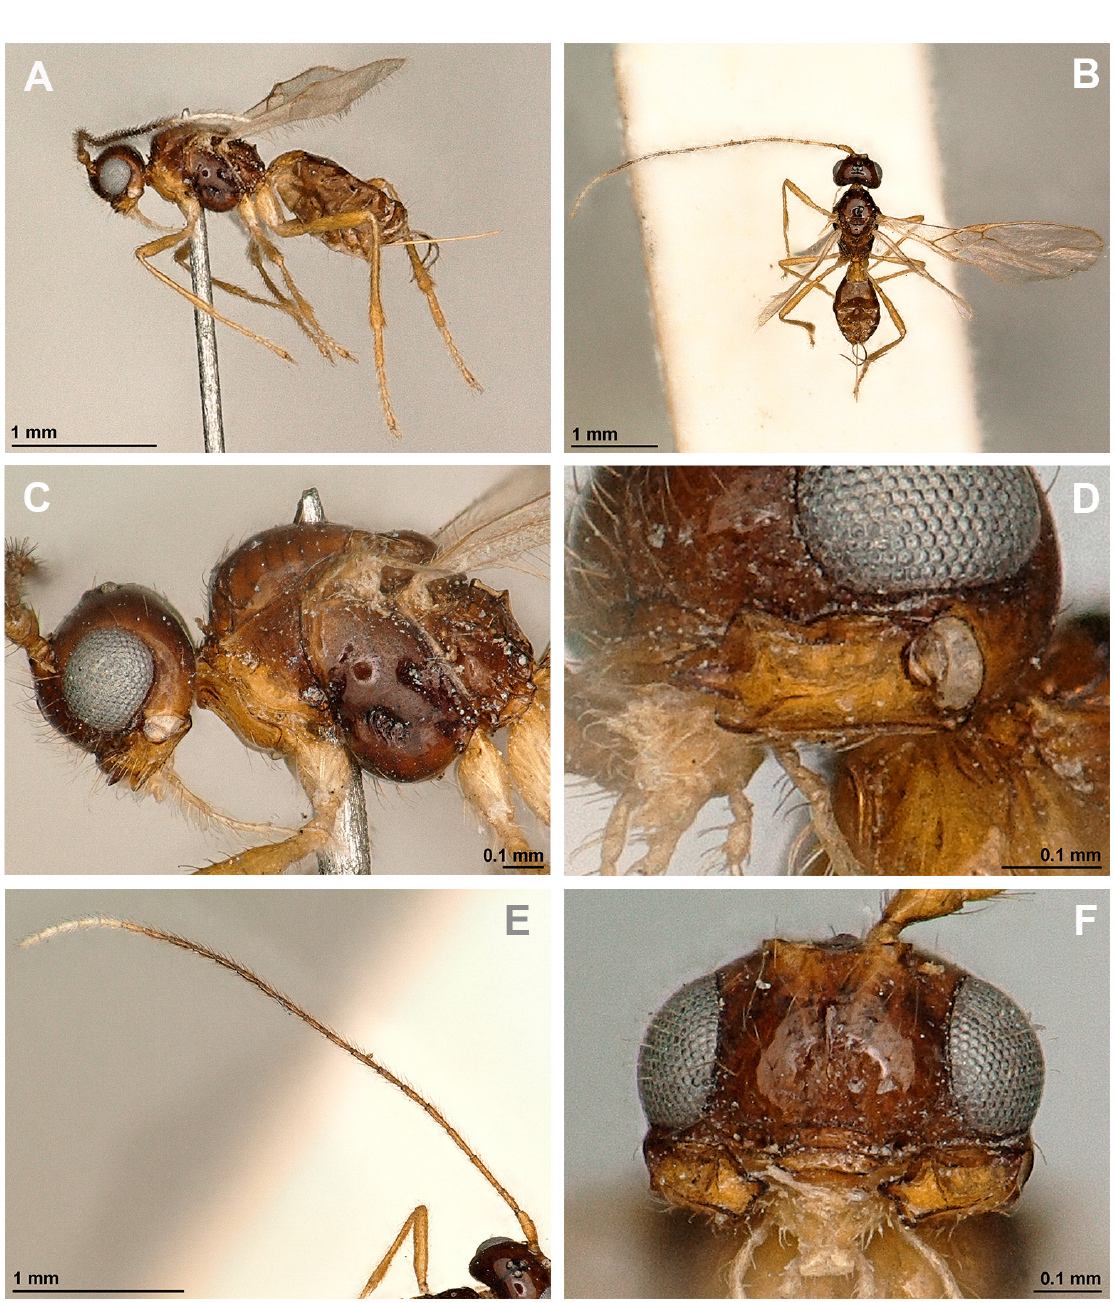
Fig. 48. Asobara pulchricornis (Szépligeti, 1911), ♀, holotype (NHMB). A . Habitus, lateral view. B . Habitus, dorsal view. C . Head and mesosoma, lateral view. D . Mandible. E . Antenna. F . Head, front